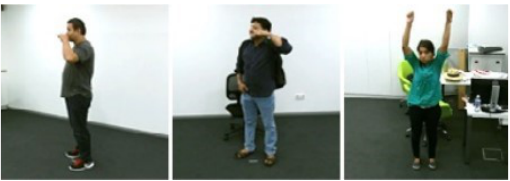
Figure 17. Samples from NTU RGB+D dataset